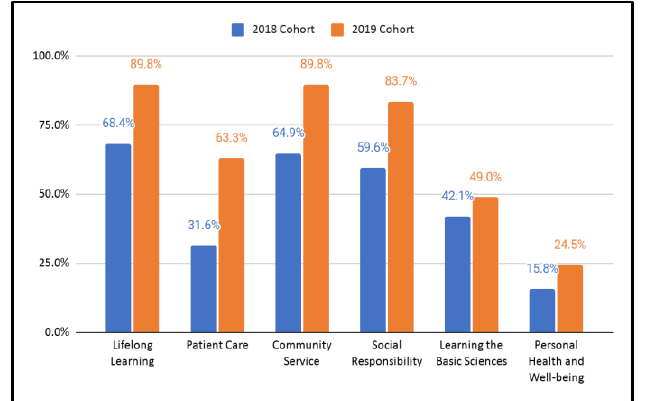
Figure 2 Percent of cohort demonstrating commitment